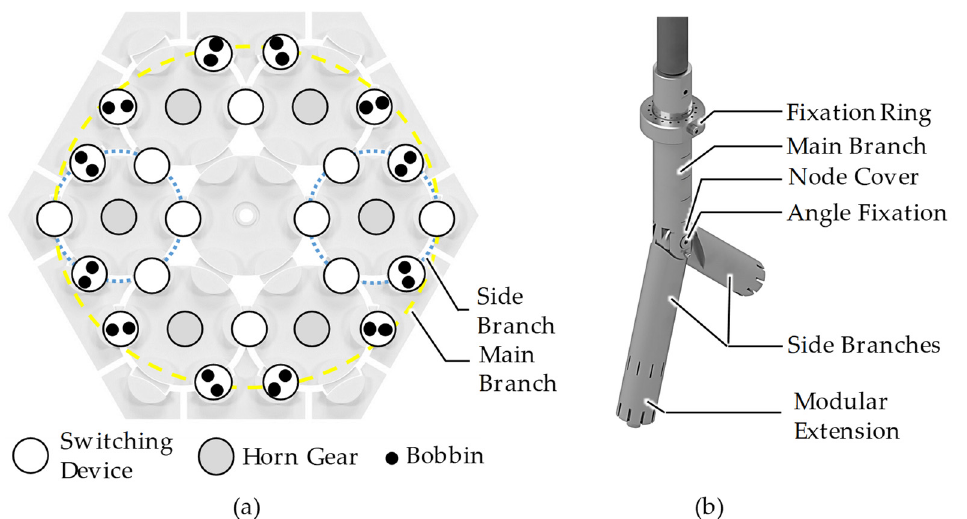
Figure 11. ( a ) Scheme of the machine bed of the 3D hexagonal braiding machine with the braiding track shown for a bifurcation stent (main branch (yellow track) and side branches (blue track)); ( b ) CAD drawing of the modular braiding core for complex stent structures.